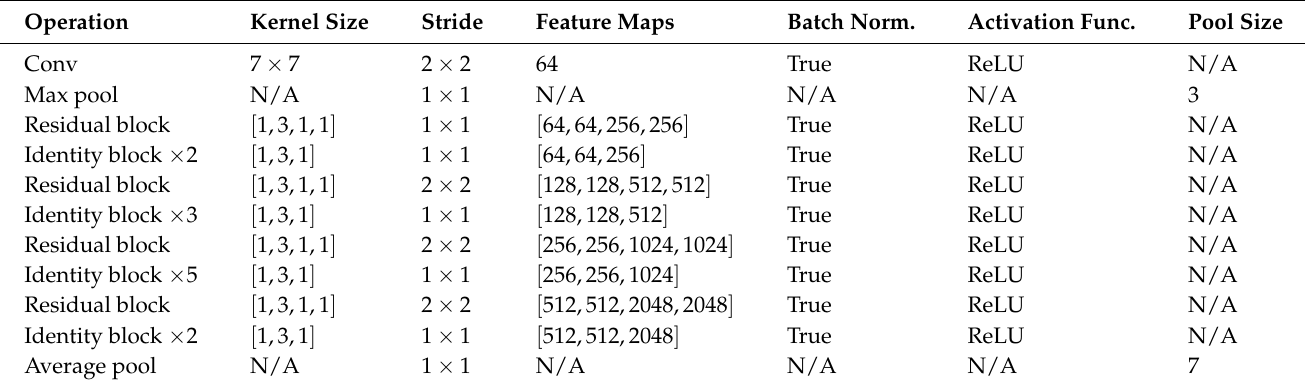
Table 1. Architecture of SegNet’s Encoder (ResNet50).